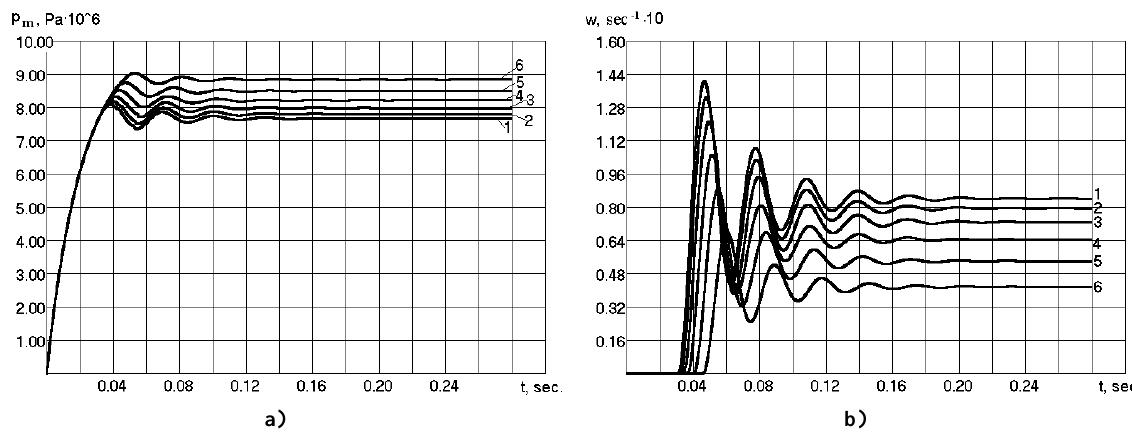
Fig. 2. Transient processes in the drive of solid waste dehydration during start-up: а) pressure at the inlet of the hydraulic motor; b) angular velocity of the